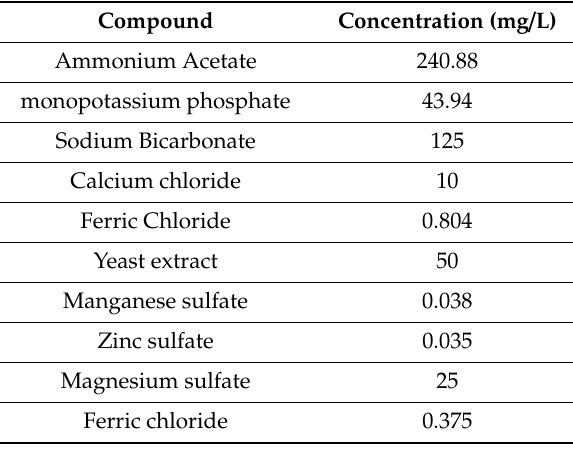
Table 1. Composition of synthetic